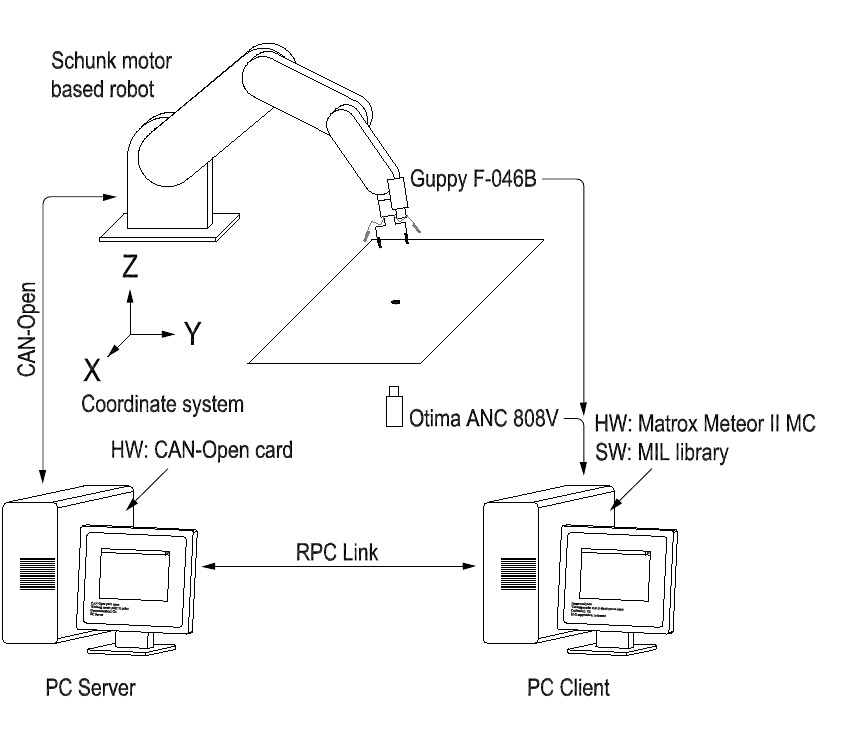
Figure 4. Experimental setup. The robot is controlled with a PC (server) connected with a visual processing computer (client) via